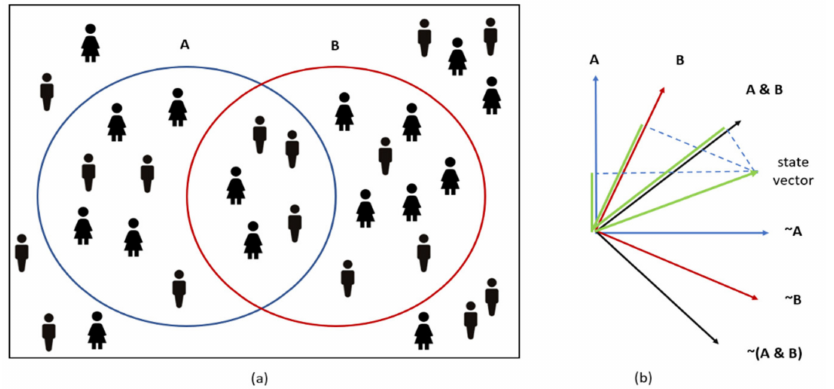
Figure 5. ( a ) The probabilities of the events A , B and A & B in classical probability: P ( A ) = 0.6; P ( B ) = 0.68; P ( A & B ) = P ( B & A ) = 0.18, whereas ( b ) presents the same three events, but in terms of quantum probability, the length of the projection of the state vector (colored in green) onto each of the basis vectors A , B and A & B indicates the probability of each of them occurring according to the state